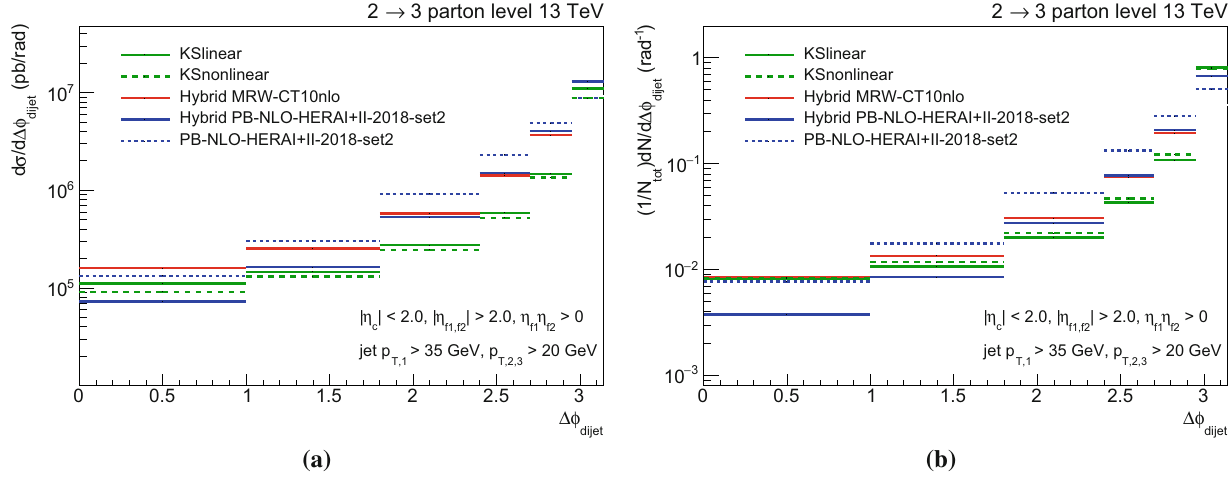
Fig. 3 Comparison of different 2 → 3 parton level predictions using both hybrid and full off-shell calculations. With KS PDFs without Sudakov resummation. Shown in absolute cross sections ( a ) and normalised distributions ( b )